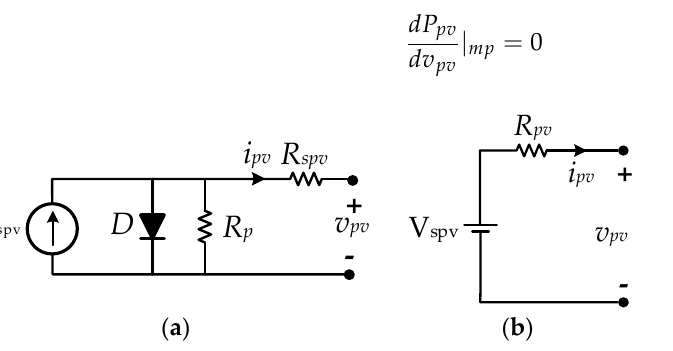
Figure 5. PV module equivalent circuit, ( a ) current source model, ( b ) Thevenin equivalent.